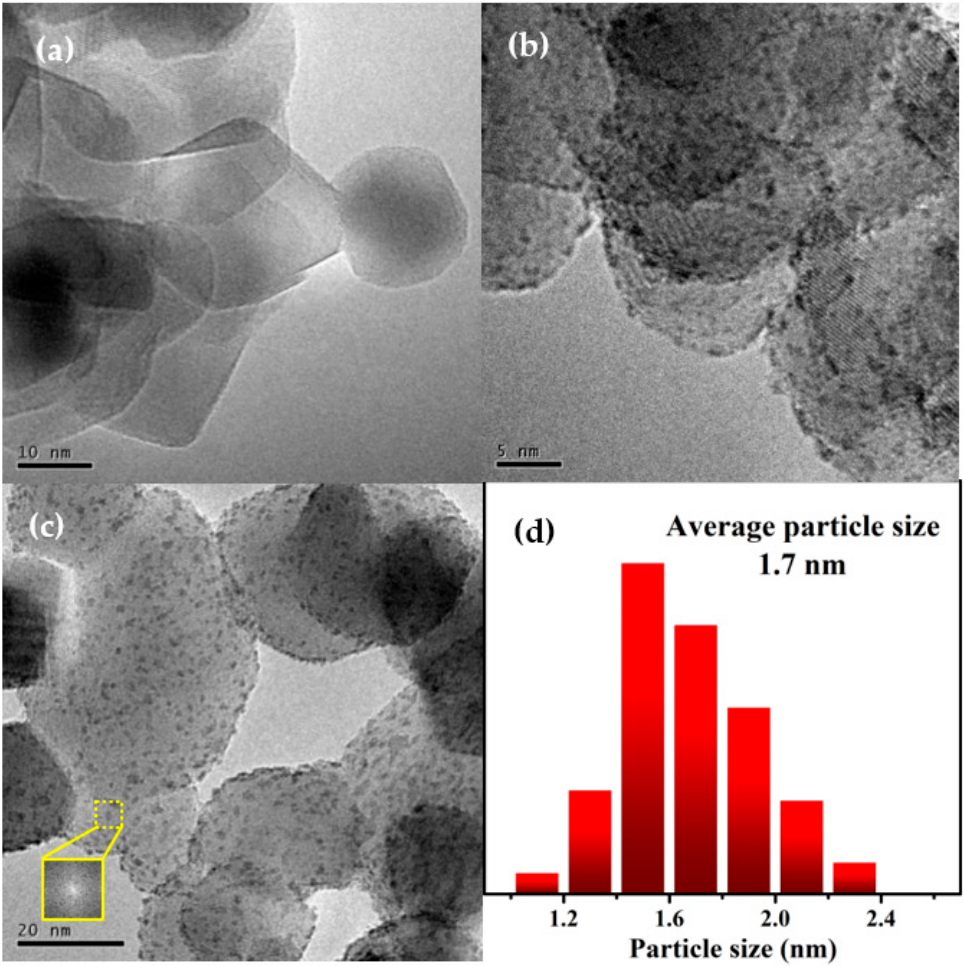
Figure 2. TEM images of ( a ) Co/TiO 2 and ( b , c ) Co 1 Re 1 /TiO 2 catalysts and ( d ) particle size distribution of Co 1 Re 1 /TiO 2 . tion of Co 1 Re 1 /TiO 2